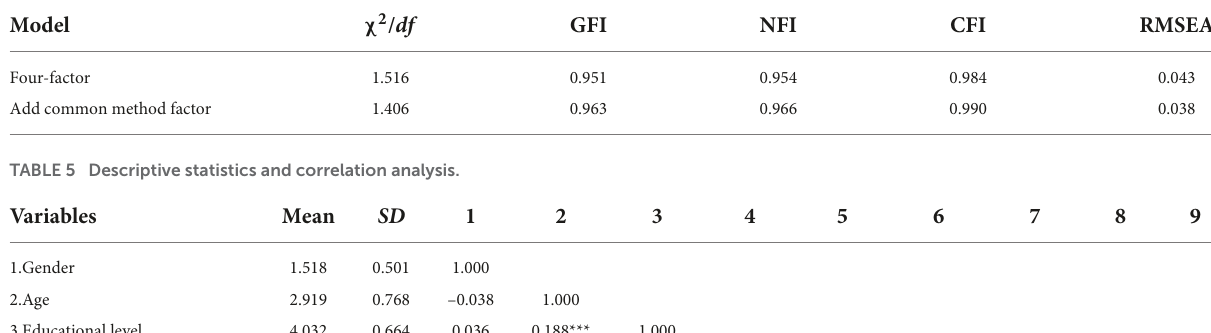
TABLE 4 Common method bias test.